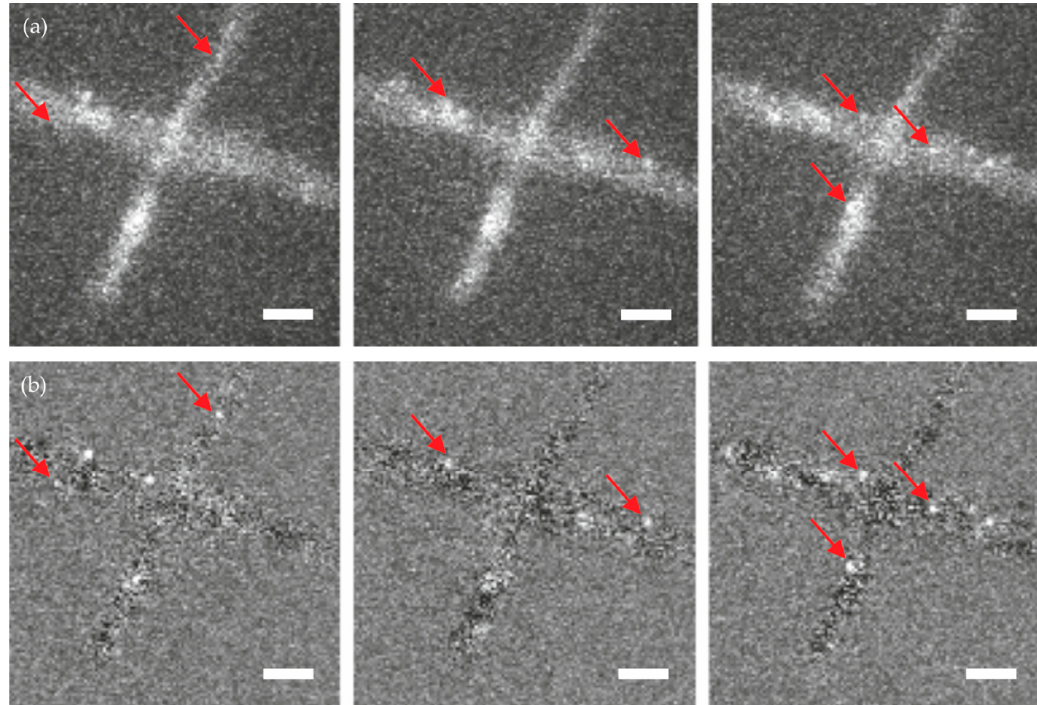
Figure 4. Comparison of T. atroviride wild-type images with overlaid simulated single molecule signals. Shown are images without ( a ) and with ( b ) temporal filtering. The red arrows indicate signals that were missed in the initial analysis but were detected after temporal filtering. Scale bar = 3 µm.